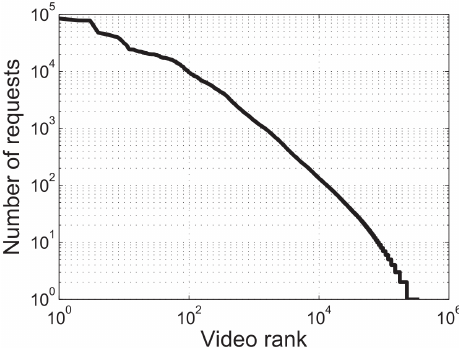
Figure 6. Mobile video popularity distribution.